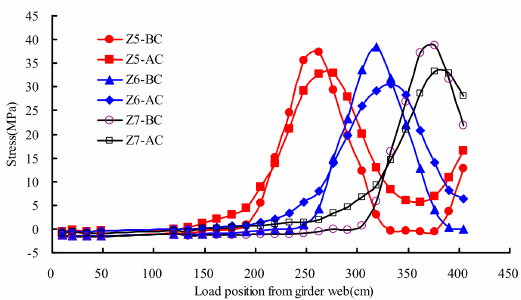
Figure 15. Stresses of U-shape rib under transverse wheel